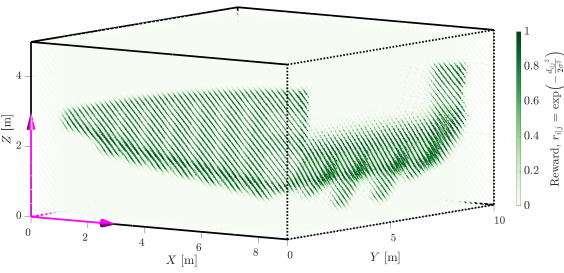
Figure 17. A lookup table generated for the truck tray with an uncertainty of 100 mm. The lookup table has been truncated, and every 1000th point is shown for visualisation purposes. The lookup frame ( ) is displayed at the origin. LU